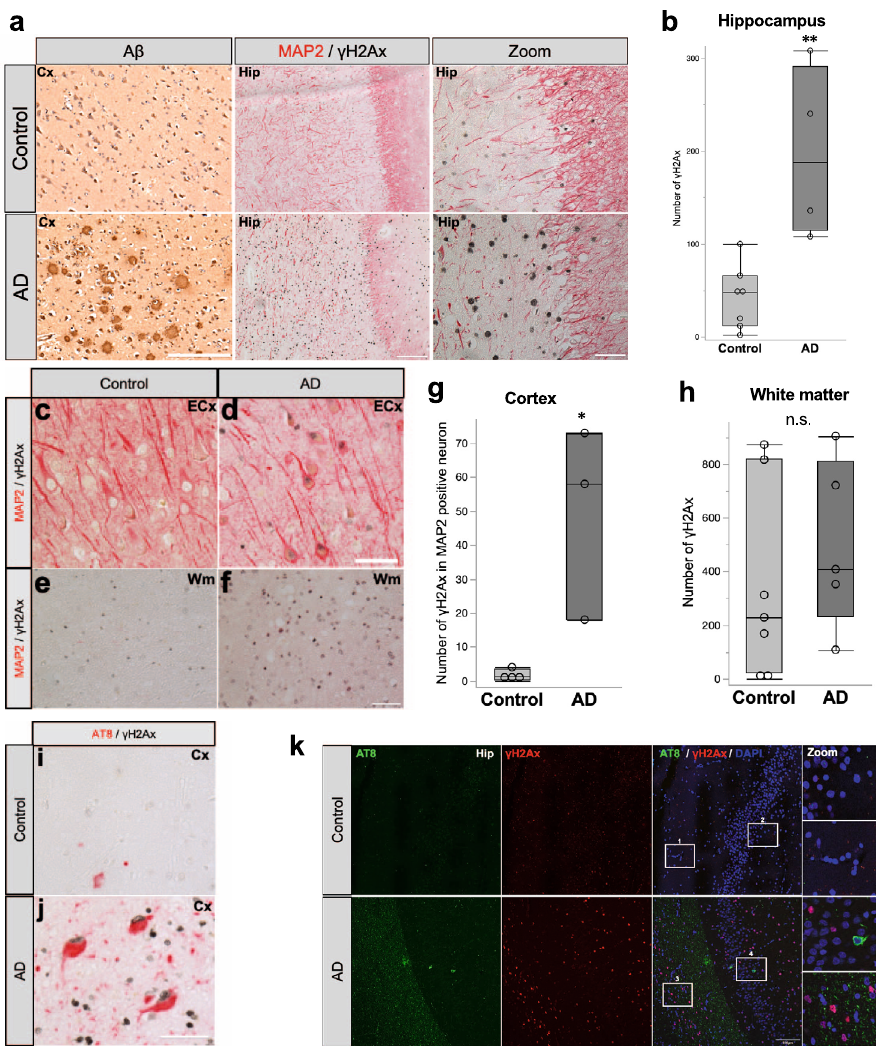
Fig. 1 Accumulation of DSB marker in AD brains. a Representative images of immunohistochemistry using DAB stain for A β in the temporal lobe cortex (Cx). Representative images of double immunohistochemistry for anti-MAP2 (neuronal marker, red) and anti- γ H2Ax (phosphorylated histone variant H2Ax at residue Ser139, DSB marker, black) in the hippocampus (Hip). Scale bars = 200 μ m for A β , 100 μ m for MAP2 and γ H2Ax, 50 μ m for magni fi ed images, respectively. b Quantitation of γ H2Ax immunoreactivity in the hippocampus. Control: n = 7, AD: n = 4, n: number of sections that contained hippocampus; ** p = 0.0027, The p -value was obtained by Student ’ s t test. c , d Representative images of double immunohistochemistry using anti-MAP2 (red) and anti- γ H2Ax (black) antibodies in the entorhinal cortex (ECx). Scale bar = 50 μ m e , f Representative images of double immunohistochemistry for anti-MAP2 (red) and anti- γ H2Ax (black) antibodies in the white matter (Wm). Scale bar = 50 μ m. g Quantitation of γ H2Ax immunoreactivity in MAP2 positive neuron in the cortex and entorhinal cortex. Control: n = 7, AD: n = 3, n: number of sections for γ H2Ax in MAP2 positive neuron stains, * p = 0.0177, The p -value was obtained by Student ’ s t test. h Quantitation of γ H2Ax immunoreactivity in the white matter. Control: n = 7, AD: n = 5, n: number of sections for γ H2Ax stains, p = 0.4619, The p -value was obtained by Student ’ s t test. i , j Representative images of double immunohistochemistry for anti- AT8 (phosphorylated at S202/T205, red) and anti- γ H2Ax (black) antibodies in the Cortex. Scale bar = 50 μ m. k Representative immuno fl uorescent images using antibodies against p-tau (AT8, green), γ H2Ax (red), and DAPI (Blue) in the hippocompus. White squares are magnifed images. Scale bar = 100 μ m. DSB DNA double-strand break, AD Alzheimer ’ s lobe cortex, entorhinal cortex, and hippocampus. In the AD to the result of MAP2 stains (Supplemental Fig. S1a,e). In the brain, we observed a large number of MAP2 and NeuN-positive hippocampus, γ H2Ax staining was frequently colocalized with neurons co-localizing with γ H2Ax in the entorhinal cortex and GFAP in AD (Supplemental Fig. S1b, f). In the cerebral white temporal lobe cortex (Fig. 1c, d, g). In contrast, most neurons matter of the temporal lobe, γ H2Ax-positive cells were similarly were γ H2Ax-negative in the hippocampus (Supplemental detected in both AD and the control (Fig. 1e, f, h) and were olig2- Fig. S1a, e). We also performed immuno fl uorescence analysis to positive (Supplemental Fig. S1d, h). Microglia and endothelial identify types of cells vulnerable to DSB damage, using antibodies cells showed almost no co-localization with γ H2Ax (Supple- against NeuN, GFAP, Iba-1, ZO-1, and olig2 as markers for mental Fig. S1c, g, i). Moreover, double immunohistochemistry neurons, astrocytes microglia, endothelial cells, and oligoden- using AT8 (phosphorylated at S202/T205) and γ H2Ax antibodies drocytes, respectively. In the entorhinal cortex and temporal lobe revealed that cortical cells containing phosphorylated tau (p-tau) cortex, NeuN - positive neurons co-localized with γ H2Ax similar occasionally displayed DSB in AD, where p-tau-positive cells were